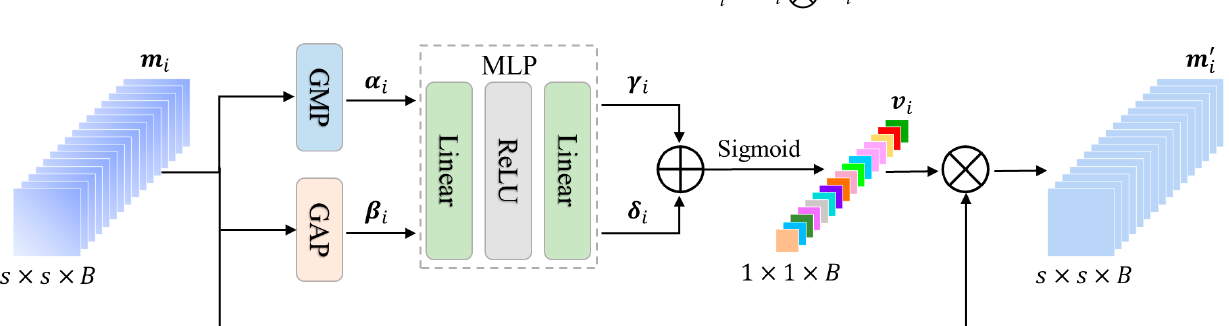
Figure 4. Detailed work fl ow of the SAAM.